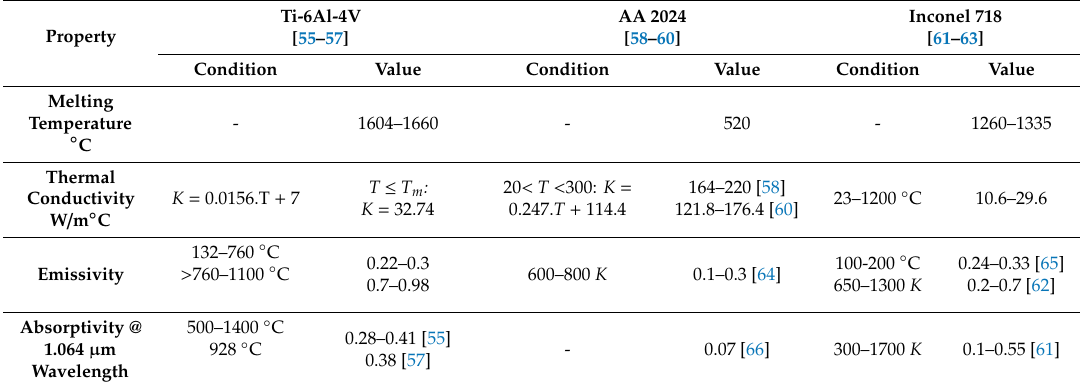
Table 1. Important properties of work materials.